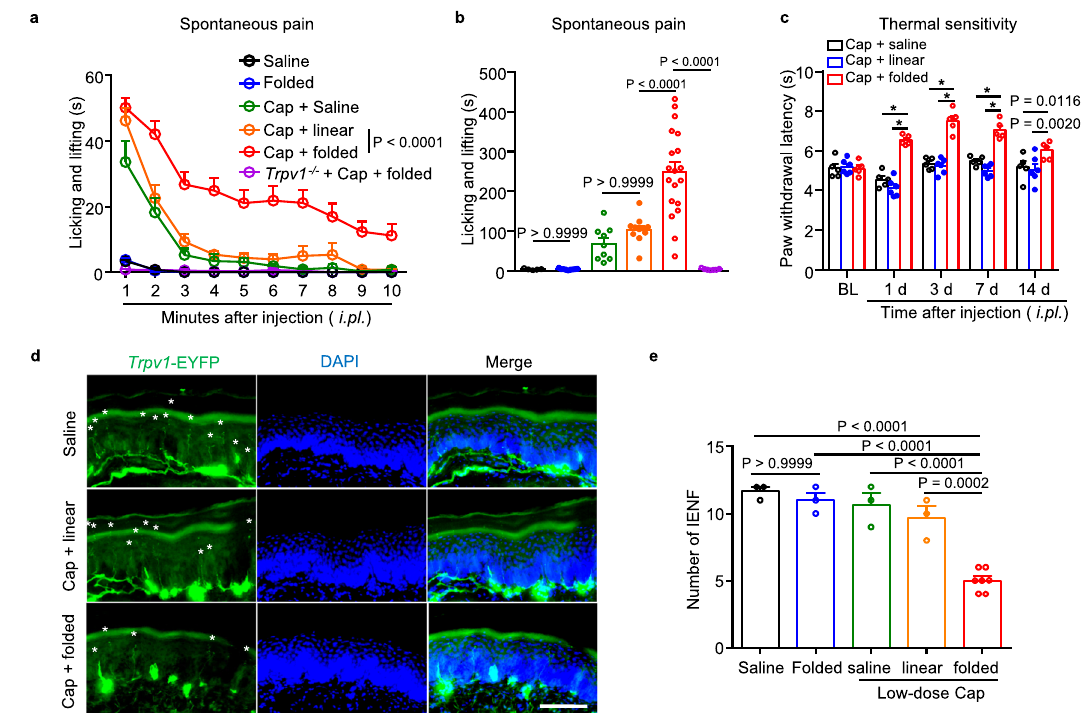
Fig. 6 | Co-application of s-RhTx with low-dose capsaicin promotes IENF degeneration to exert long-lasting analgesic effect on thermal sensitivity in mice. Effect of folded s-RhTx on capsaicin-induced spontaneous pain. The time spentinwithdrawal, fl inching,orlickingtheinjectedpawwasrecordedandblindly countedeveryminuteafterinjection( a );andtotaltimeofspontaneouspainwithin 10minsafterinjectionwasanalyzed( b ).2 μ goffoldeds-RhTxorlinears-RhTxwith capsaicin (200ng) in 20 μ l saline was injected. Saline: n = 5, Folded: n = 9, Cap + saline: n = 9, Cap + linear: n = 11, Cap + folded: n = 19, Trpv1 − / − + Cap + folded: n = 7 biologically independent mice. P value was labeled in the fi gure, two-way ANOVA for a ,one-wayANOVAfor b . c Effectofs-RhTxonthermalsensitivity.2 μ goffolded- s-RhTx or linear-s-RhTx with capsaicin (200ng) in 20 μ l saline was injected. Data